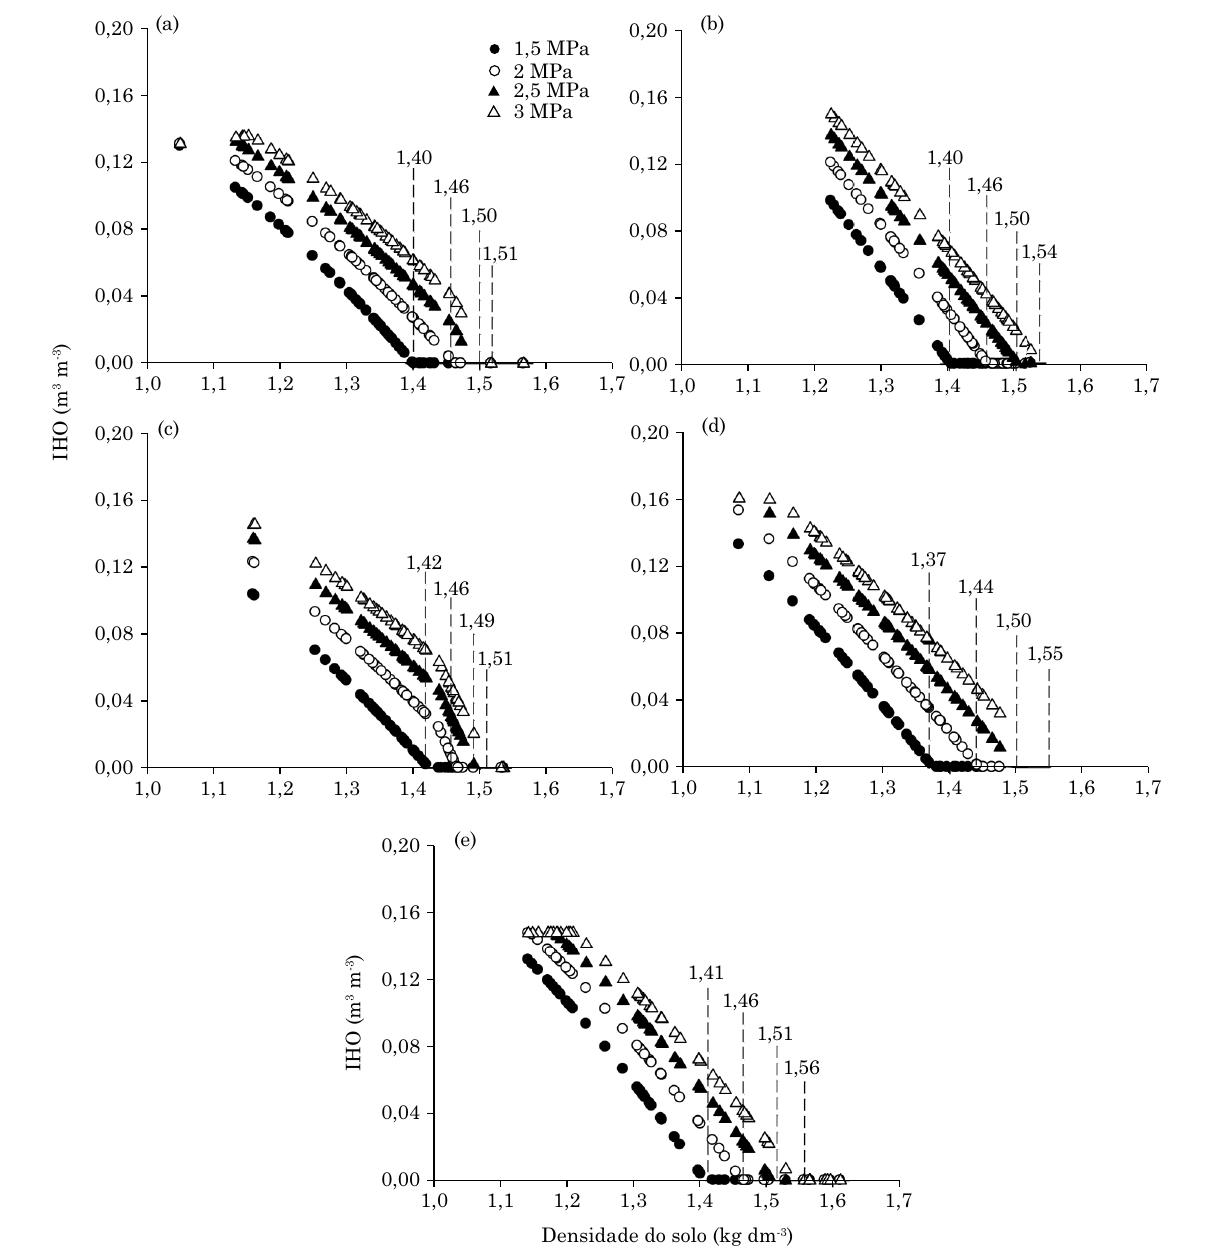
Figura 2. Intervalo hídrico ótimo sob diferentes níveis críticos de resistência mecânica do solo à penetração. (a) Solo construído cultivado com Hemarthria altíssima (T1); (b) Solo construído cultivado com Paspalum notatum (T2); (c) Solo construído cultivado com Cynodon dactilon (T3); (d) Solo construído cultivado com Urochloa brizantha (T4) e (e) Solo construído sem a implantação de plantas de cobertura (T5). θ CC = 0,001 MPa; θ PMP = 1,5 MPa e θ PA = 10 %. As linhas verticais pontilhadas indicam, da